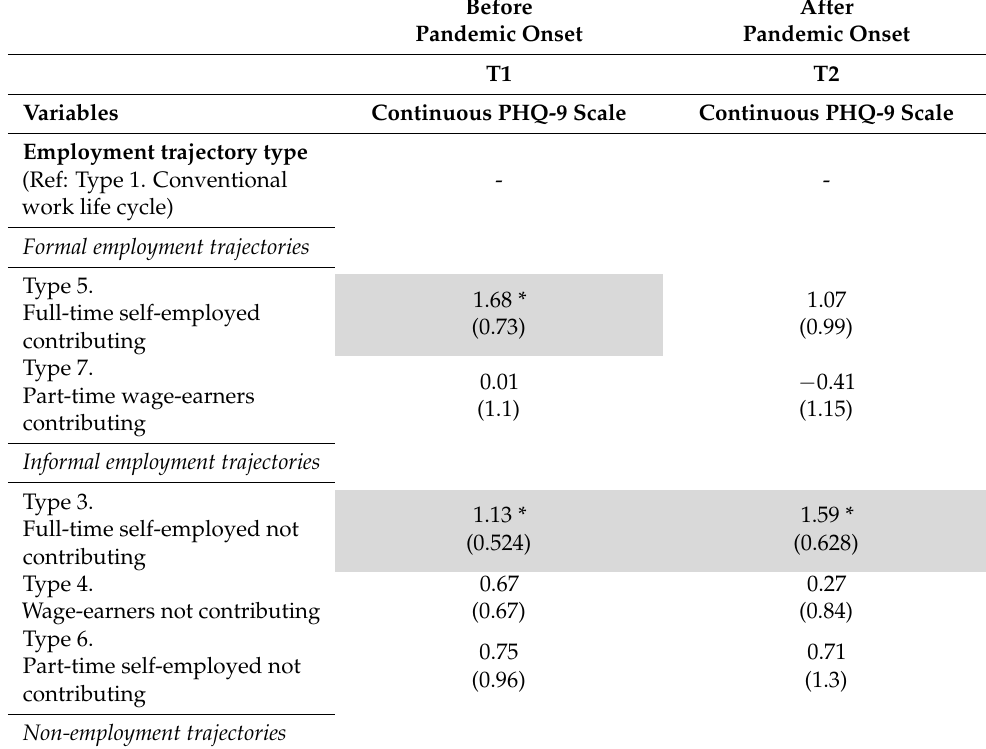
Table A4. Multivariate linear regression models at two time points (all trajectory